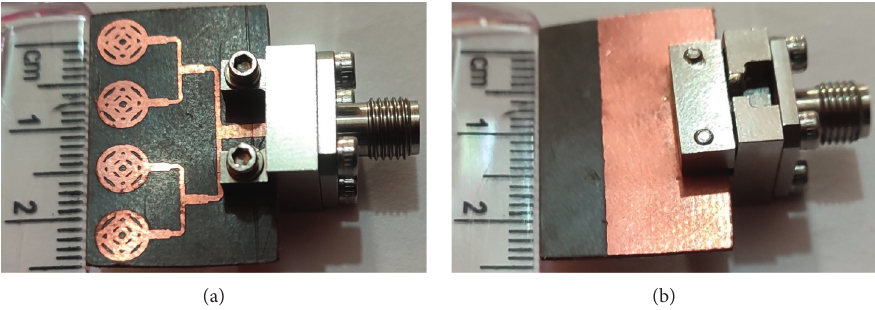
Figure 6: Fabricated prototype of the proposed array: (a) front view; (b) back